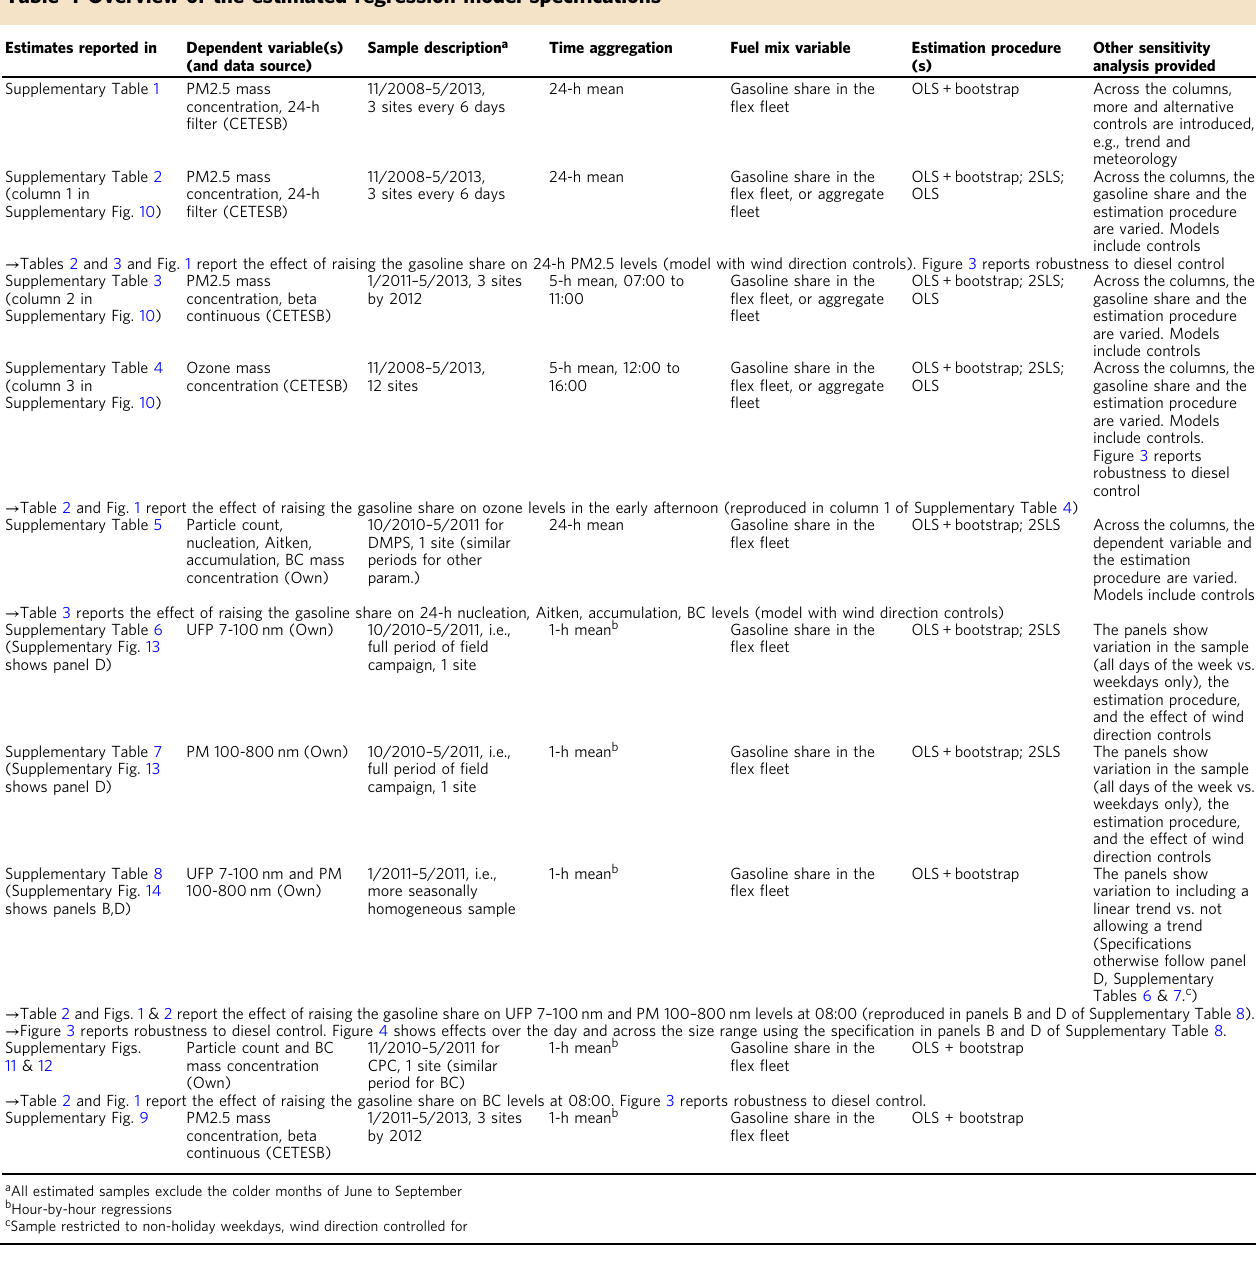
→ Table 2 and Fig. 1 report the effect of raising the gasoline share on BC levels at 08:00. Figure 3 reports robustness to diesel control. Supplementary Fig.